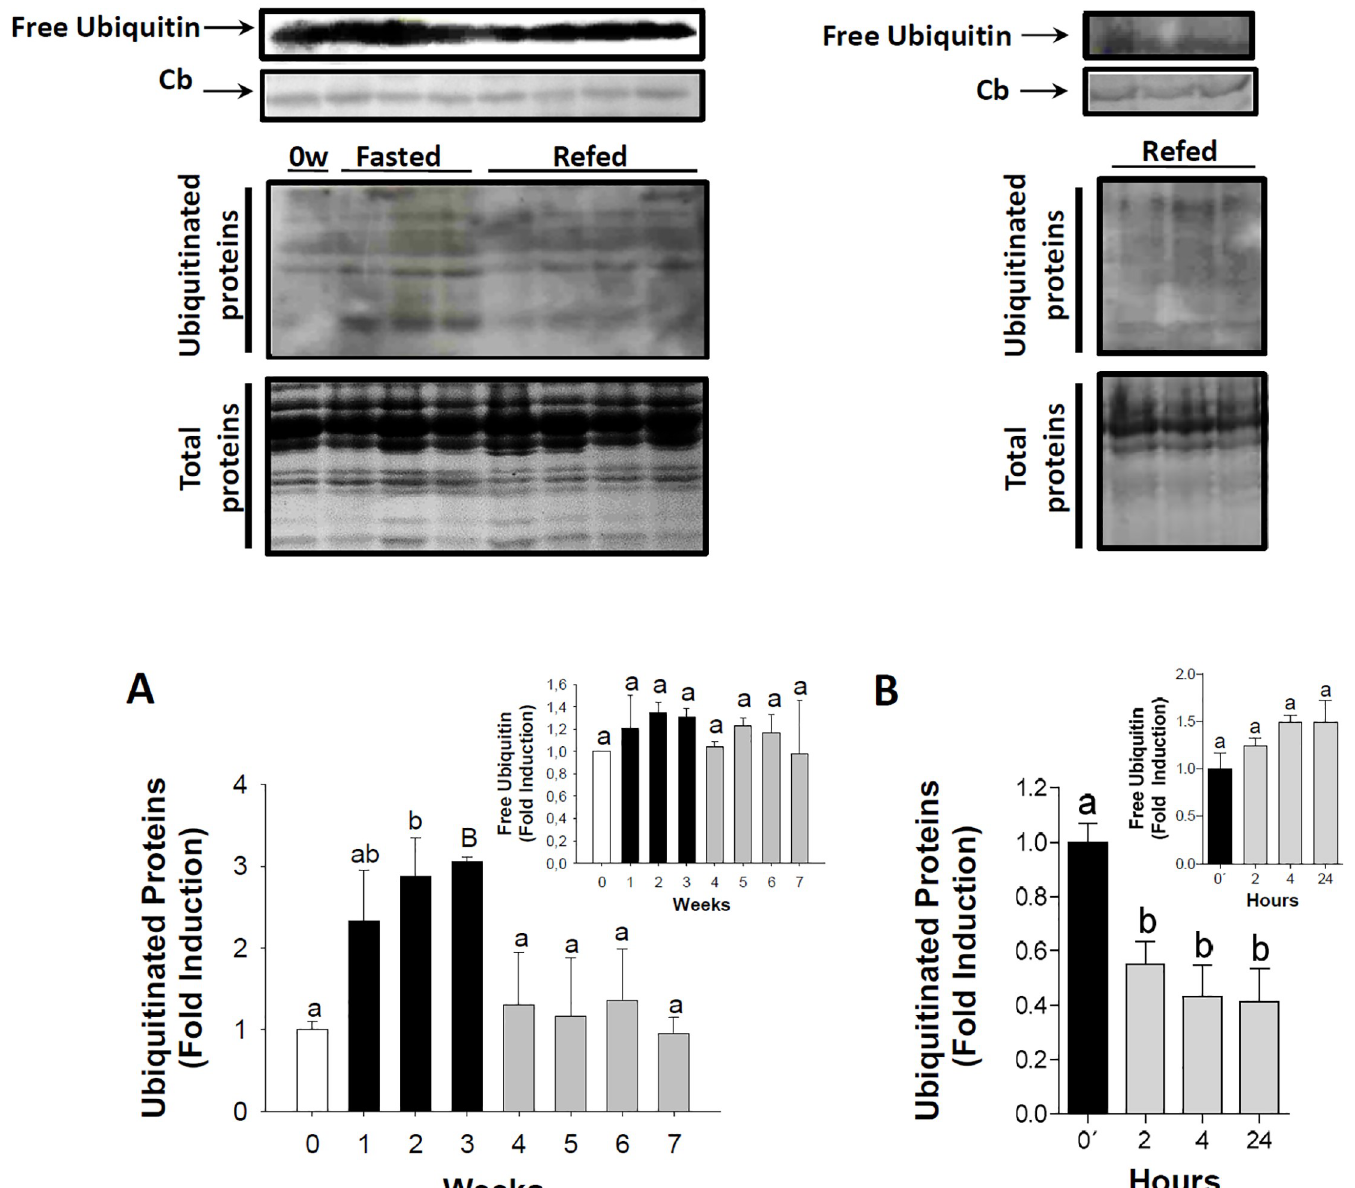
Fig 6. Ubiquitination of proteins in the skeletal muscle during long-term fasting and refeeding and short-term refeeding. Ubiquitinated protein during long-term fasting and refeeding (A) and short-term refeeding (B). Inserts in A and B show the amount of free ubiquitin during the trial. Percentage of ubiquitinated proteins during long-term fasting and refeeding and short-term refeeding are shown in graphs below the image data. These data were normalized to total protein levels. White, black and grey bars represent periods of feeding, fasting and refeeding, respectively. A probability level of P < 0.05 (lower case letters) and P < 0.01 (by upper case letters) was used to indicate statistical significances. Results are expressed as means ± SEM (n = 3). Different letters indicate significant differences among sampling points of each group, respectively. Abbreviations: Cb = Coomassie blue staining; 0 0 = zero hour of short-term refeeding corresponding to the end of fasting period (week